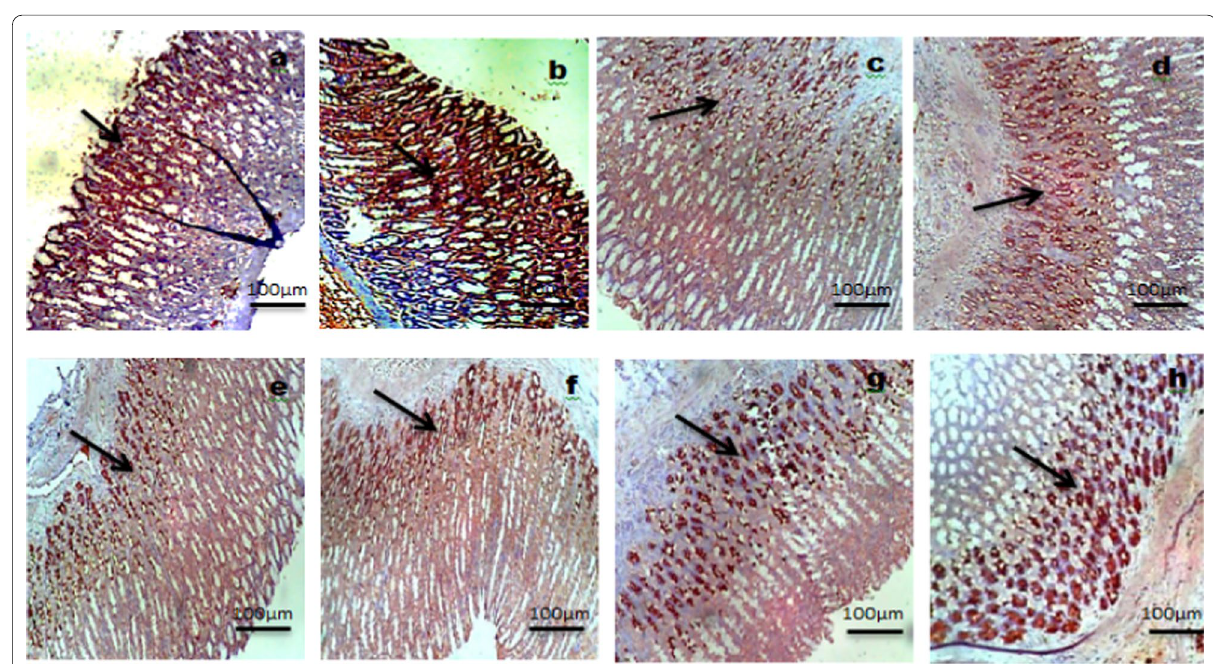
Fig. 17 IHC slides for evaluation of CD31 positive immunoreactive cells during healing of acetic acid stomach ulcer pretreated with folic acid and omeprazole. (H&E, X100). a Acetic acid stomach ulcer untreated (Day 5). b Acetic acid stomach ulcer treated with 2 mg/kg Folic acid (Day 5). c Acetic acid stomach ulcer treated with 3 mg/kg Folic acid (Day 5). d Acetic acid stomach ulcer treated with Omeprazole (Day 5). e Acetic acid stomach ulcer untreated (Day 10). f Acetic acid stomach ulcer treated with 2 mg/kg Folic acid (Day 10). g Acetic acid stomach ulcer treated with 3 mg/kg Folic acid (Day 10). h Acetic acid stomach ulcer treated with Omeprazole (Day 10). Black arrow: Point of =